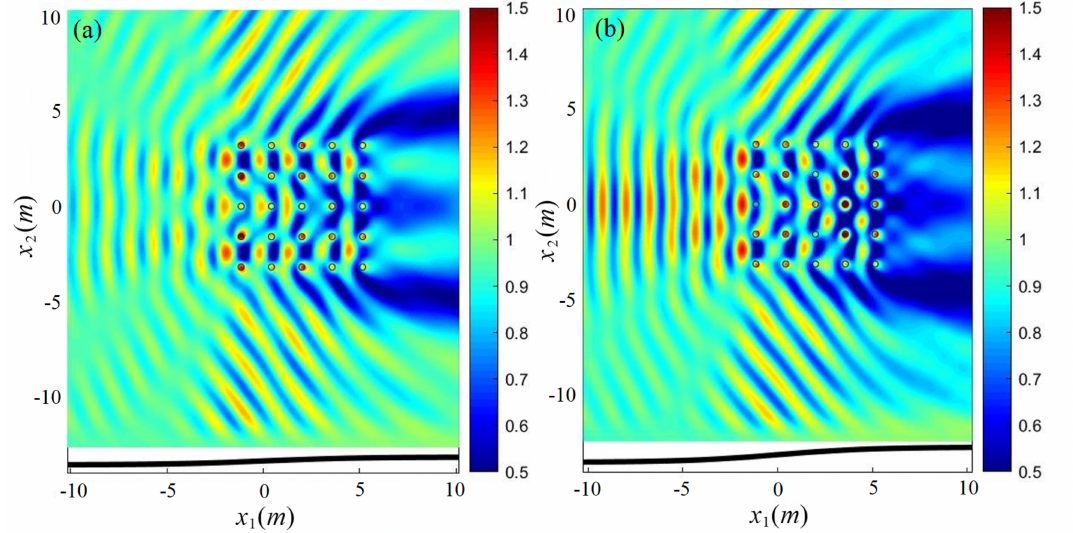
Figure 13. Same as in Figure 12 for the 5 × 5 WEC arrangement modelled by inclusions, but in sloping seabeds of a mean characteristic slope of ( a ) 4% and ( b ) 8%, shown in the lower plots.